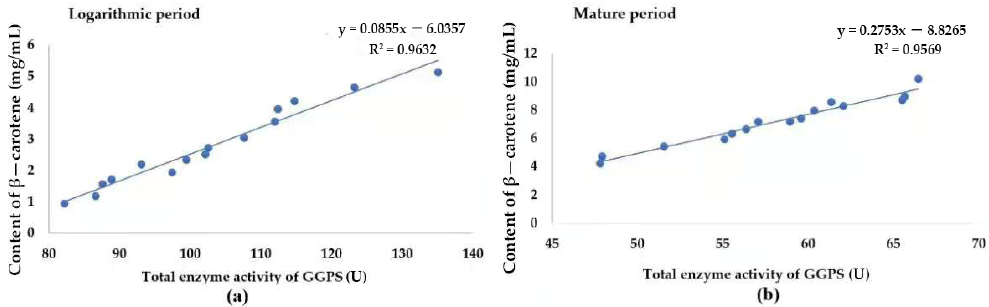
Figure 6. Linear relationship of β -carotene and GGPS enzyme activity in two periods. ( a ) In the logarithmic period. ( b ) In the mature period.